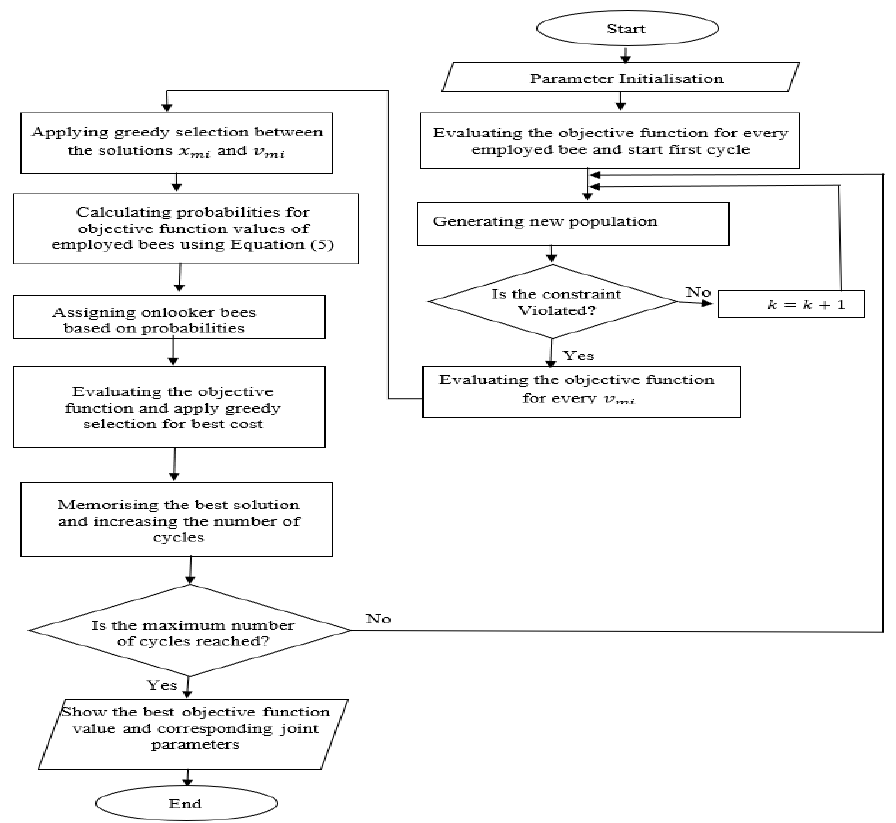
Figure 1. Flowchart of the Artificial Bees Colony algorithm.